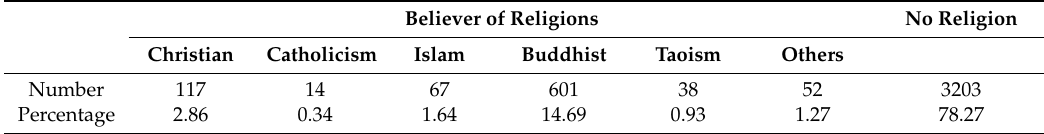
Table 1. Religious affiliation among urban